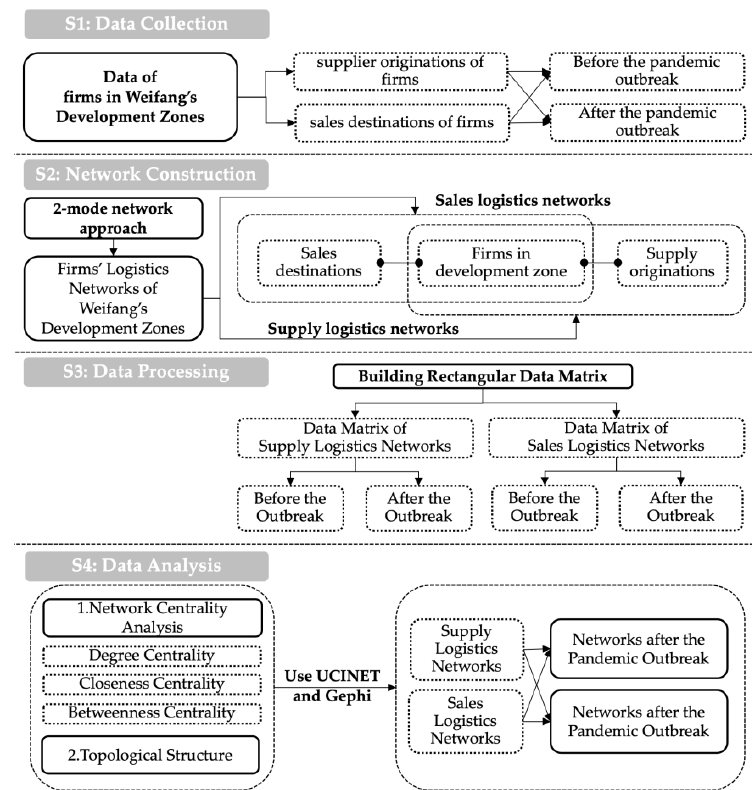
Figure 1. Analysis steps.